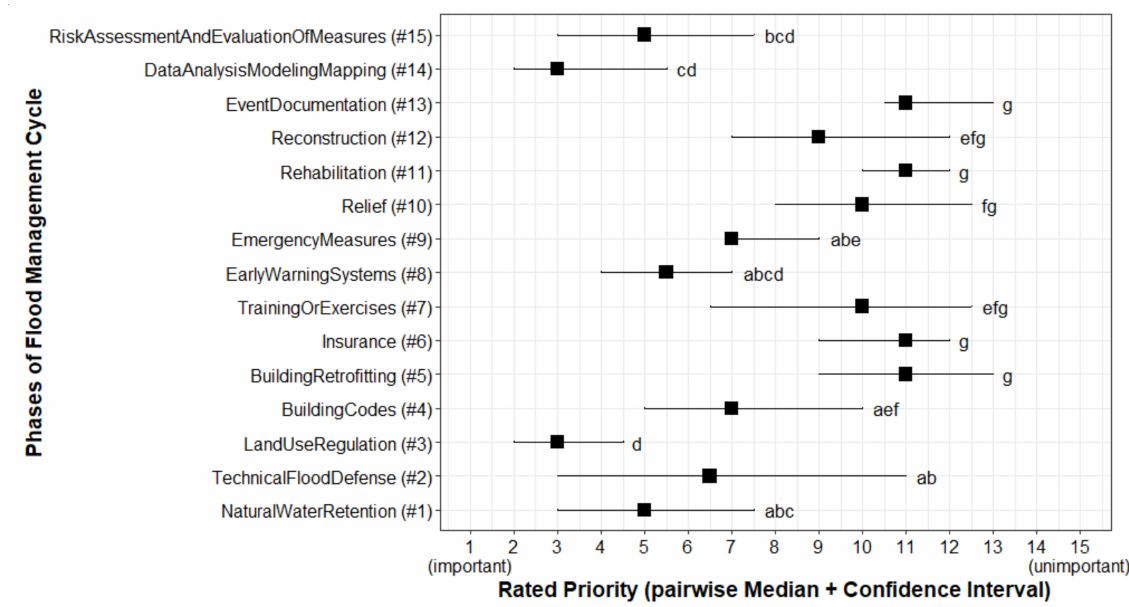
Figure 9. Statistical differentiation by the Friedman–Conover Post hoc test of phases in FM cycle regarding their importance (Friedman χ fm and Kendall Wt test-statistics: p < 2.2 × 10 − 16 , df = 14, χ fm = 108.22, Wt = 0.276). Ratings of phases sharing a letter (e.g., “a” in EmergencyMeasures and NaturalWaterRetention) could not be statistically differentiated. The # followed by a number refers to their position in the FM cycle (see Sections 1 and 3.1.2).